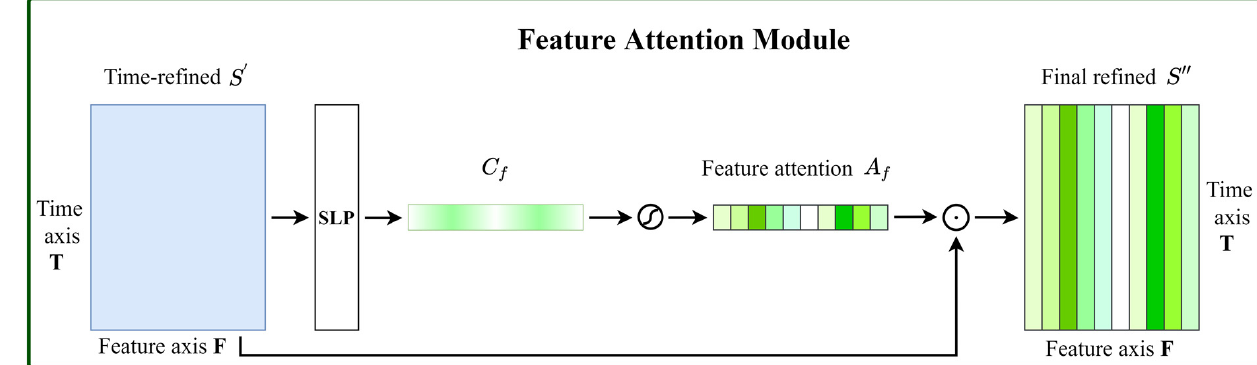
Figure 6. Diagram of the feature attention